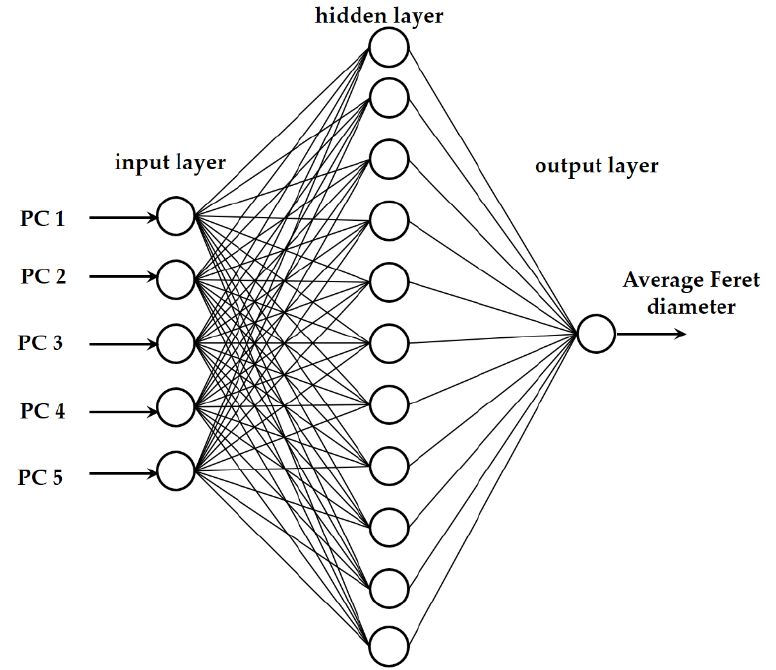
Figure 1. Graphical representation of the neural network model.